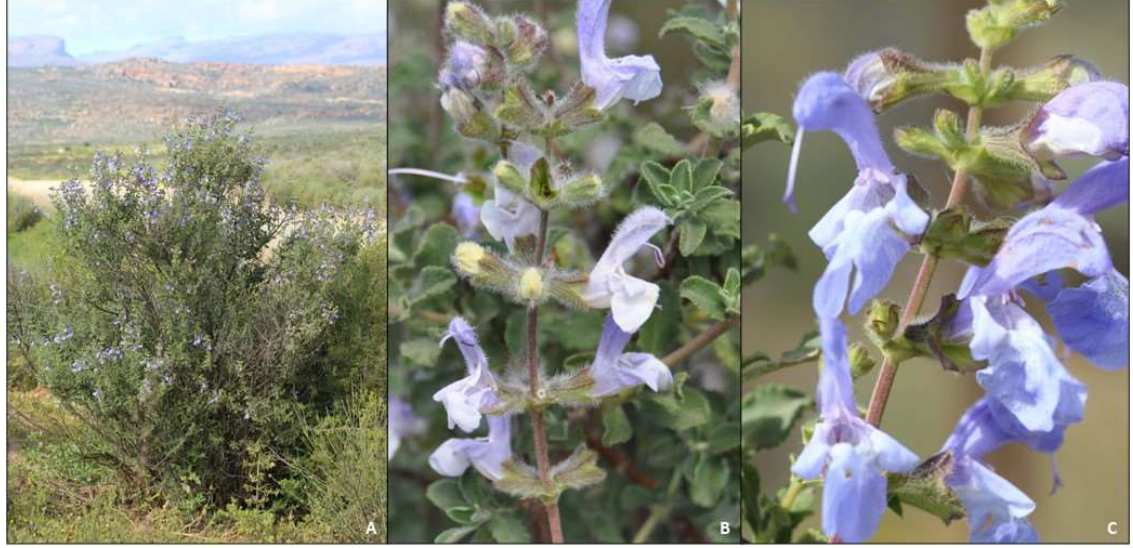
Figure 4. Morphology and diagnostic characters of Salvia africana . ( A ) habit (Cederberg); ( B ) inflorescence and leaves (Malmesbury); ( C ) flowers (Cederberg; note hirsute calyx). All photographs taken by B.-E. Van Wyk.